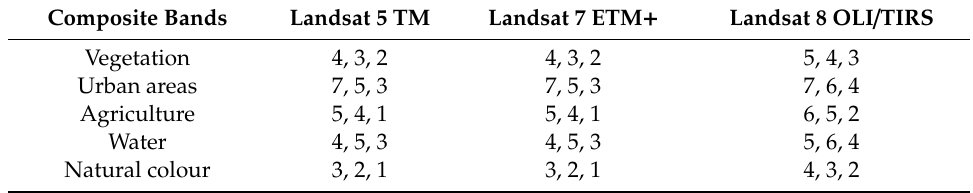
Table 1. Composition of Bands for Landsat 5 TM, Landsat 7 ETM + and Landsat 8 OLI / TIRS